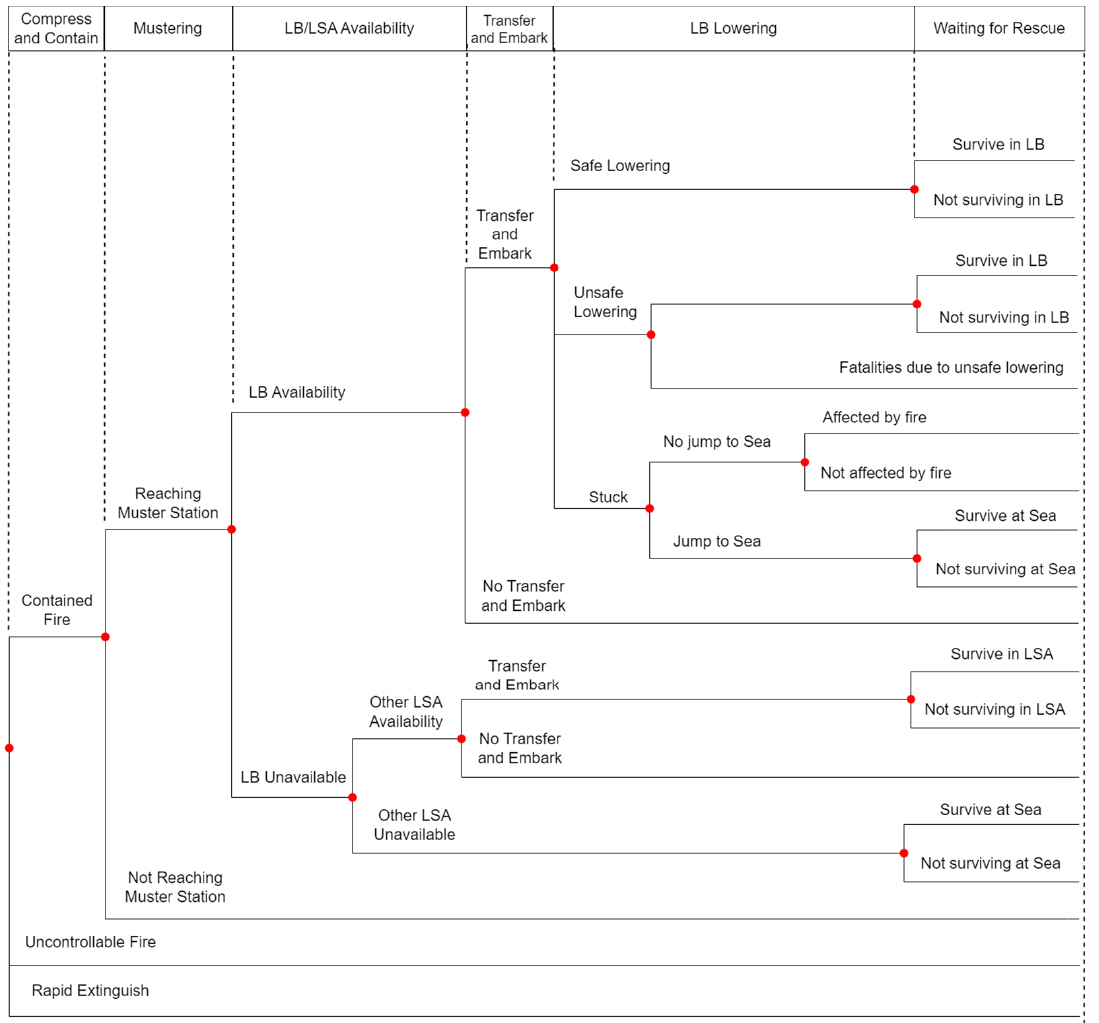
Figure 4. Event tree for fire/explosion accidents.